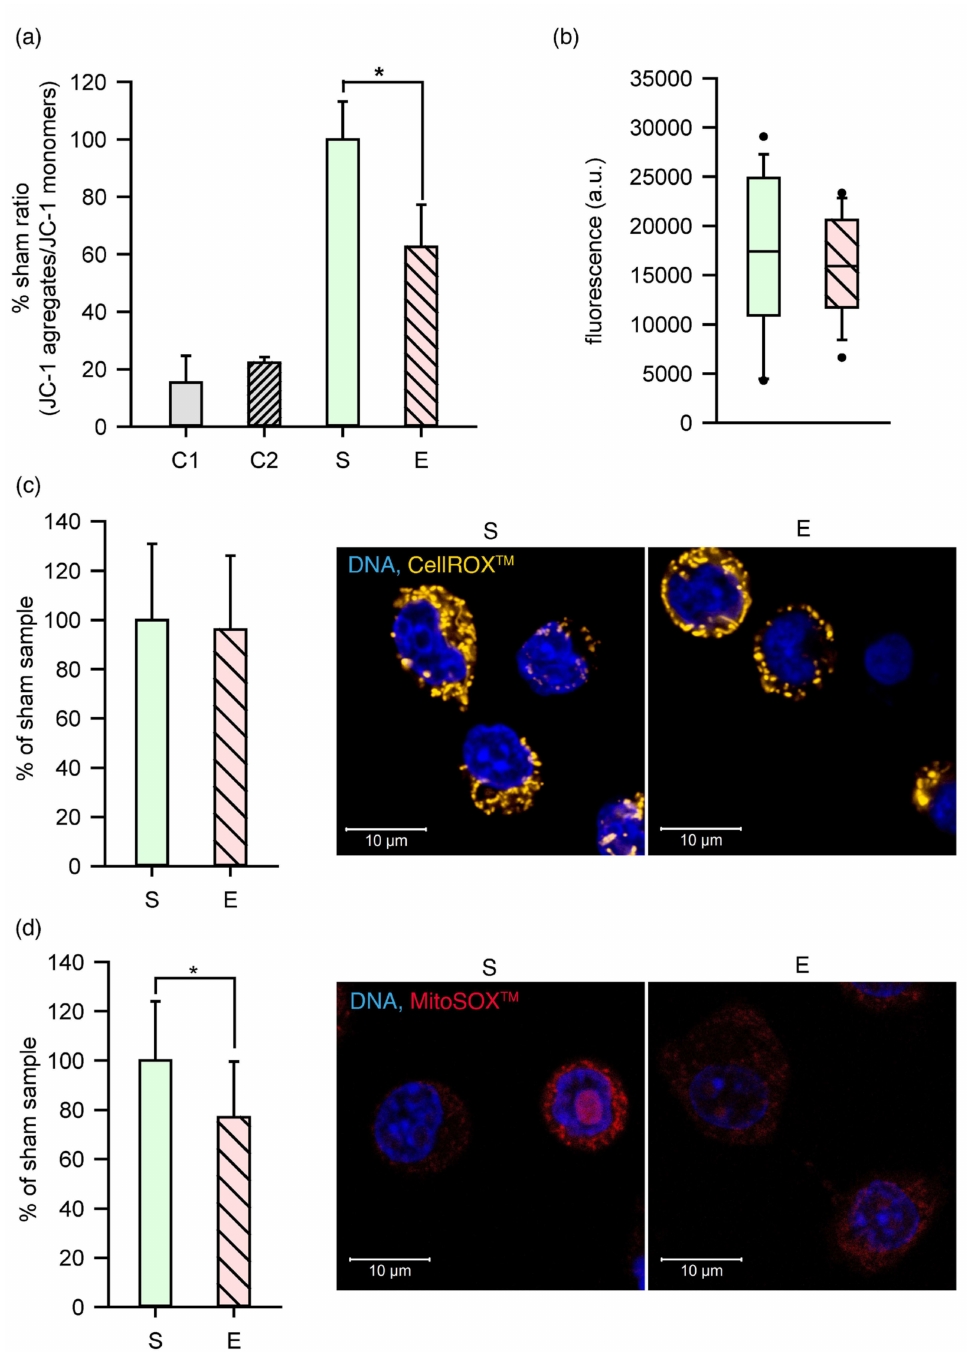
Figure 5. Redox balance, metabolic activity, and reactive oxygen species production in TM3 cells. S: sham-exposed cells. E: nsPEF-exposed cells. ( a ) The mitochondrial membrane potential was assayed with a JC-1 probe and recorded with flow cytometry. C1: positive control with valinomycin. C2: positive control with CCCP. Each bar shows the mean ( ± SD) of four independent experiments, with at least two biological repetitions. ( b ) TM3 metabolic activity measured with a PrestoBlue ® assay. The boxes show the median value of four independent experiments, with at least three biological and six technical repetitions per condition for each experiment ( n = 68). The 25th and 75th percentiles are indicated by the bottoms and tops of the boxes, respectively. Whiskers: 5th and 95th percentiles. ( c ) Left: Formation of reactive oxygen species determined with the CellROX™ Orange Reagent, presented as a percentage of the average fluorescence values for S samples ( ± SD). Right: Images of cells under CLSM, the orange fluorescent signals are specific for reactive oxygen species detection, blue signals are from Hoechst-stained cells’ nuclei. ( d ) Left: Superoxide production by mitochondria measured with the MitoSOX™ Red Mitochondrial Superoxide, presented as a percentage of the average fluorescence values for S samples ( ± SD). Right: